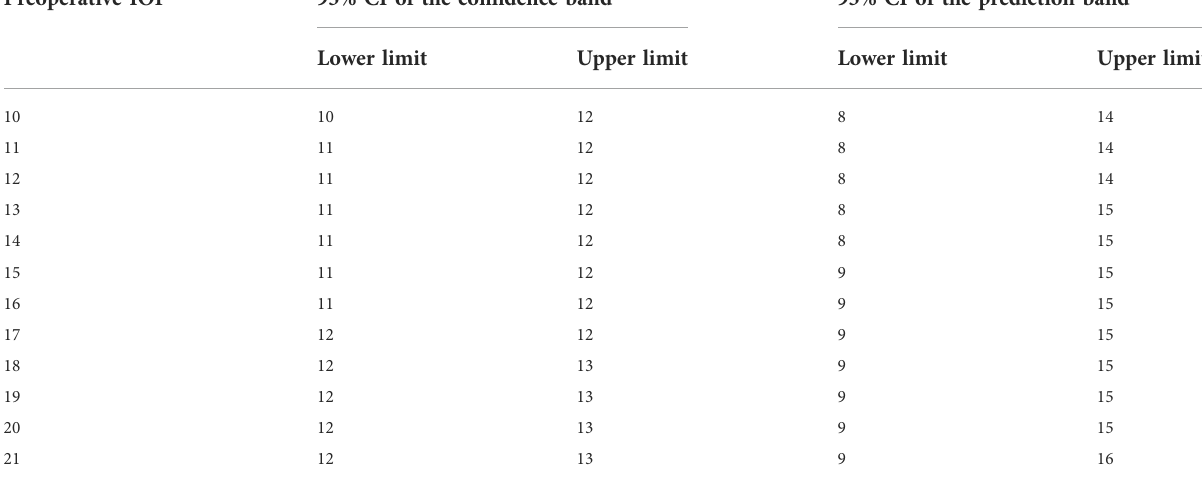
TABLE 5 Estimated con fi dence band and prediction band of postoperative IOP GAT . Preoperative